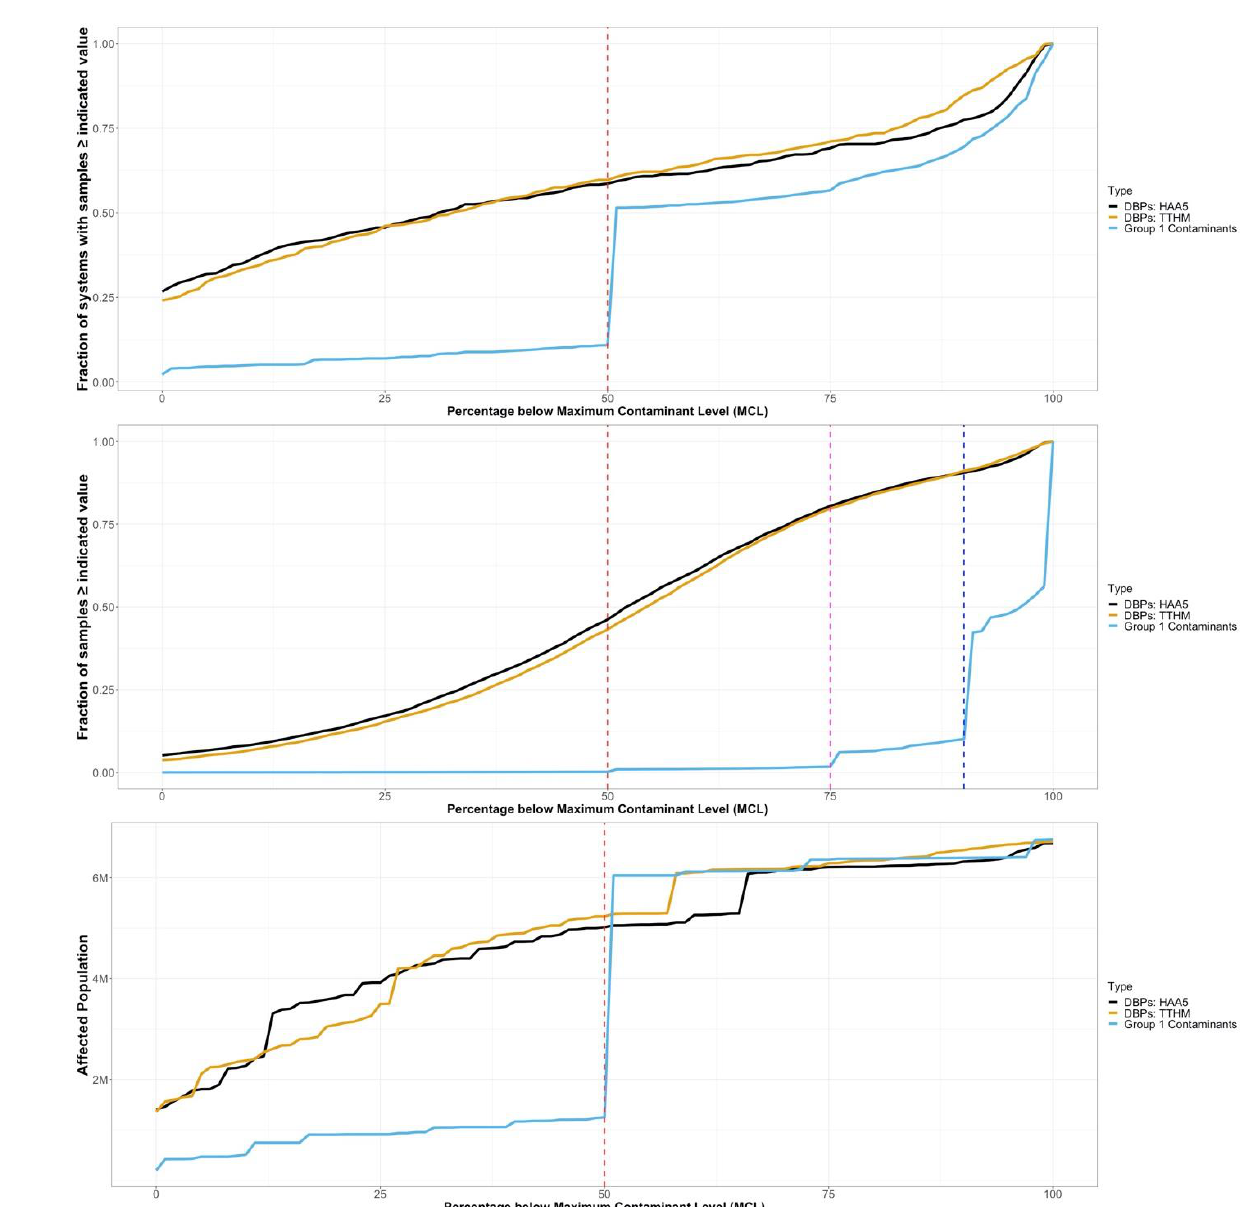
Figure 4. Cumulative distributions of ( a ) fractions of systems with samples greater or equal to indicated value concentration below percentages of MCL , ( b ) fractions of samples greater or equal to indicated value, ( c ) and affected population for group 1 contaminants of Inorganic, organic, and radionuclides (cyan), TTHM (gold), and HAA5 (black). The punctuated changes at 50%, 75%, and 90 % of the MCL are indicated by the vertical dash lines in red, magenta, and blue, respectively.